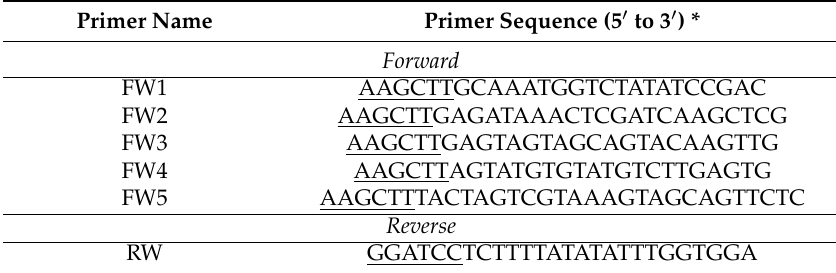
Table 1. Oligonucleotide primers used for PCR cloning and deletion of BvcPPOP